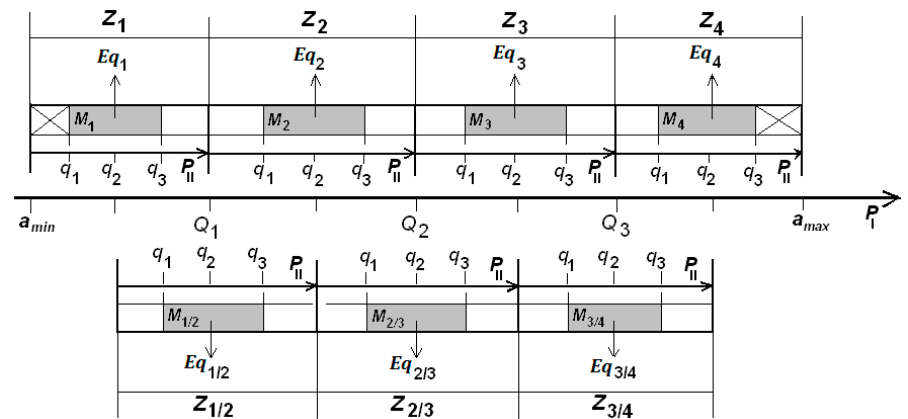
Figure 4. Method of division of soils into sets (Z 1 , Z 1 / 2 , Z 2 , Z 2 / 3 , Z 3 , Z 3 / 4 , Z 4 ) and subsets ( M 1 , M 1 / 2 , M 2 , M 2 / 3 , M 3 , M 3 / 4 , M 4 ) used to create regression equations ( Eq 1 , Eq 1 / 2 , Eq 2 , Eq 2 / 3 , Eq 3 , Eq 3 / 4 , Eq 4 ) to the soil penetration resistance ( PR ) in relation to ordering parameters P I (stage I) and P II (stage II).